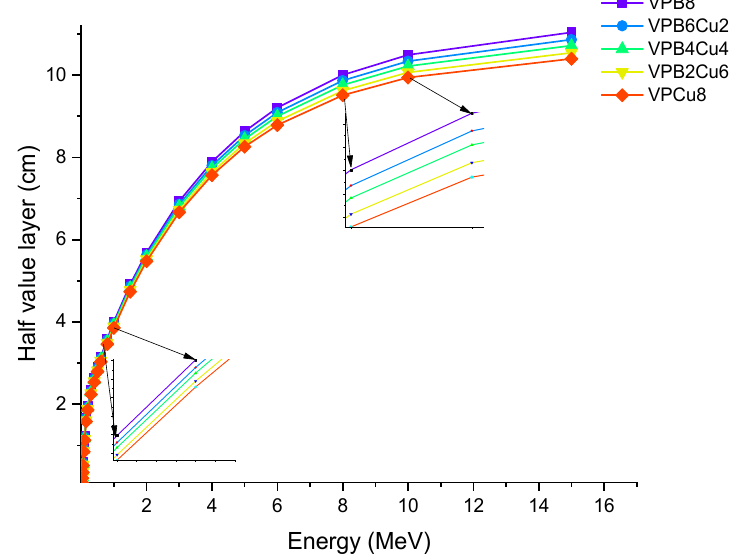
Figure 7. Variation of half value layer (T 1/2 ) against photon energy for VPB x Cu y glass samples.